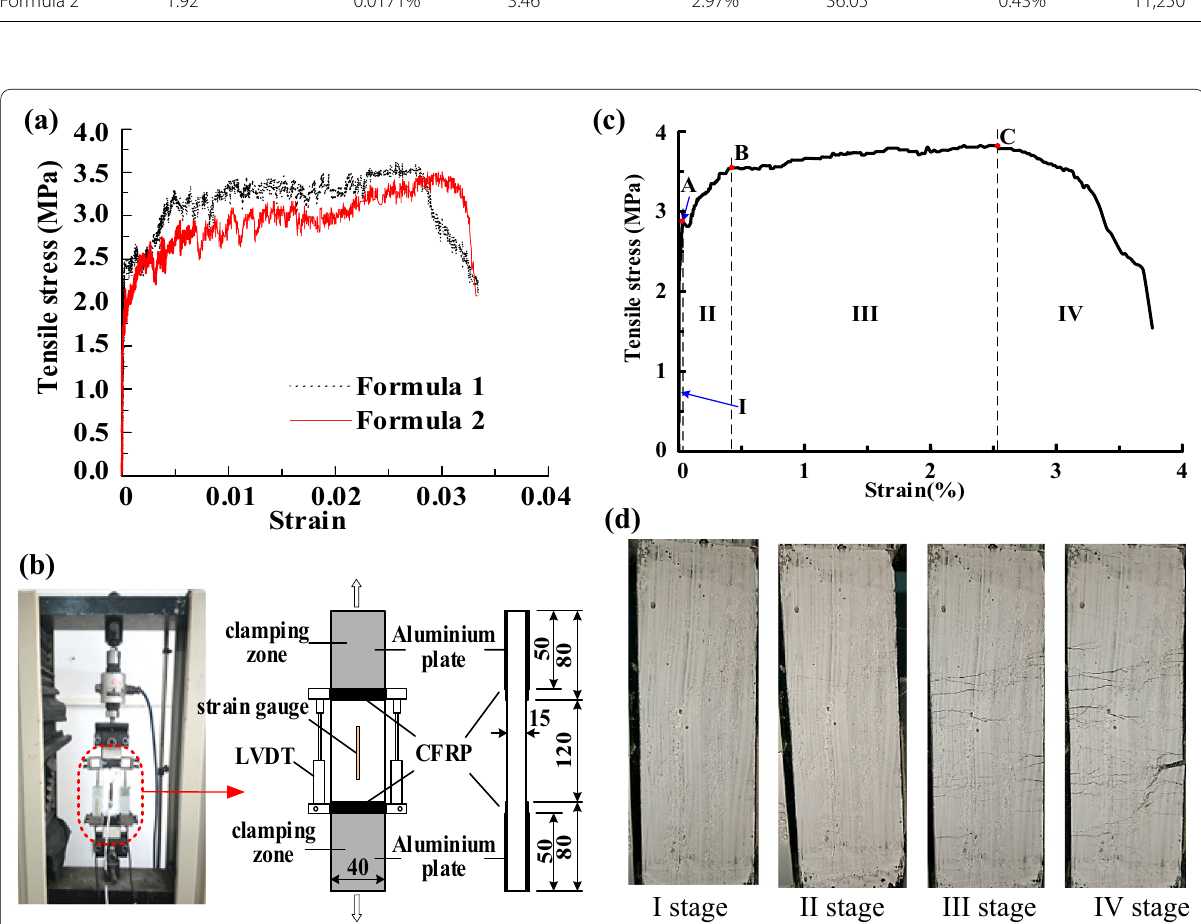
Fig. 2 The tension test setup and results of ECC: a direct tensile stress–strain relationship of ECC thin plates; b tensile test device of ECC; c typical tensile stress–strain curve of ECC and d crack patterns in different stages corresponding to the stress–strain curve of